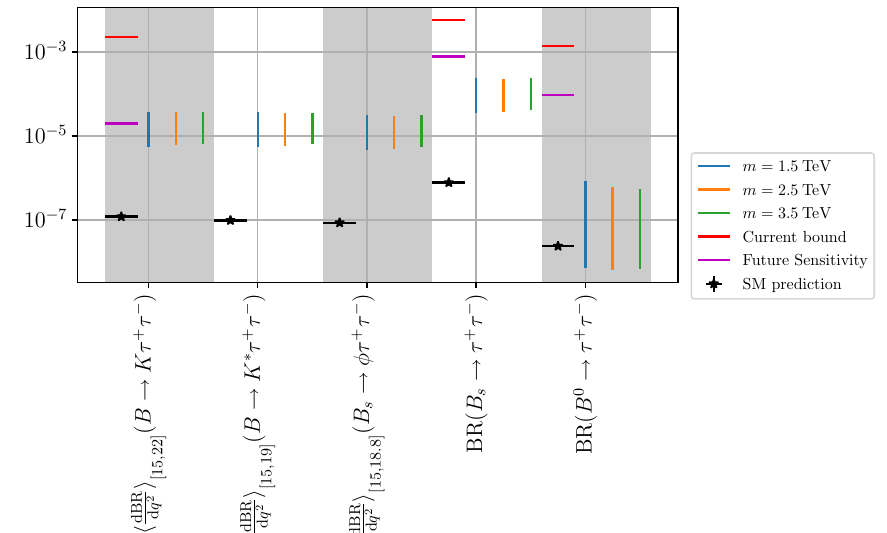
Fig. 4 Predictions for several leptonic and semileptonic B ( s ) to τ + τ − decays, for three benchmark values of the vector leptoquark mass (coloured vertical bars). Also displayed, to the left of the different pre- dictions, are the current experimental limits and the future projected